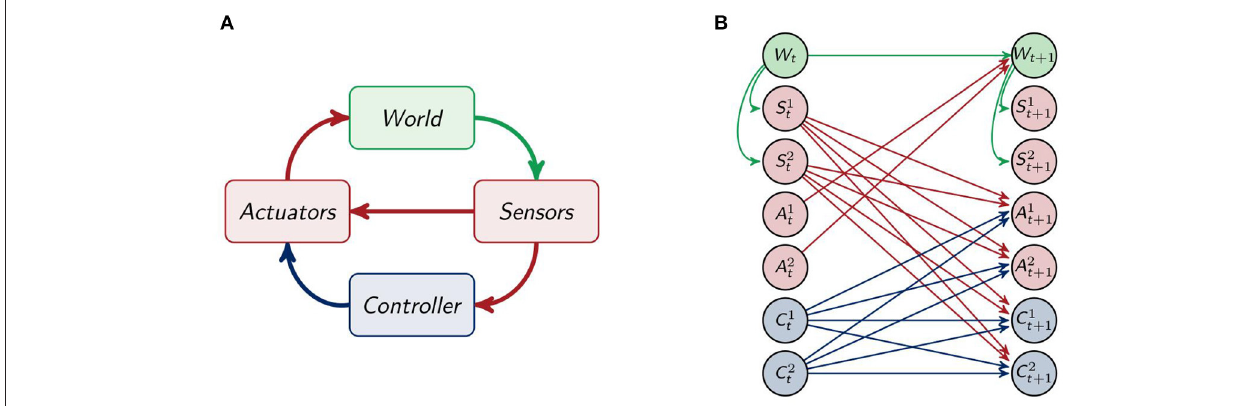
FIGURE 2 | (A) The sensori-motor loop and (B) the architecture of the agents.